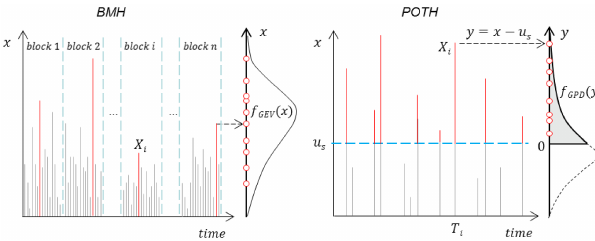
Figure 1. A sketch of a systematic record. To the left: the block maxima data set (for the BMH method). To the right: the POT data set (for the POTH method). In POT only surges X i > u s are mod- eled through exceedances Y i = X i − u s . The distribution F(X) is known only for the upper part x > u s